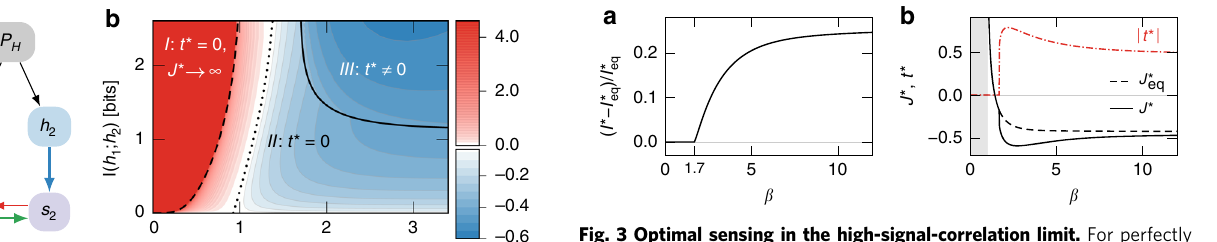
Fig. 3 Optimal sensing in the high-signal-correlation limit. For perfectly correlated Gaussian signals, the nonequilibrium information gain is largest in the noiseless limit. We consider a sensor complex driven with signal ffiffiffiffiffiffi p H = ( h , h ) with P ¼ e (cid:3) h 2 = 2 = 2 π . a The nonequilibrium gain as a function H of sensor reliability β . The gain grows from zero at β = 1.7 and increases with β , suggesting that the enhancement results from the ability to distinguish additional signal features. b Optimal sensing strategy for varying noise levels. For β < 1 (shaded), the mutual information is maximised by an equilibrium system ( t * = 0) with in fi nitely strong coupling. The equilibrium strategy remains optimal for β < 1.7 with a coupling J * (solid) that decreases with β and exhibits a sign change at β = 1.4. At bigger β , the optimal coupling in the equilibrium case (dashed) continues to decrease but equilibrium sensing becomes suboptimal. For β > 1.7, the mutual information is maximised by a fi nite nonequilibrium drive (dot-dashed) and negative coupling.